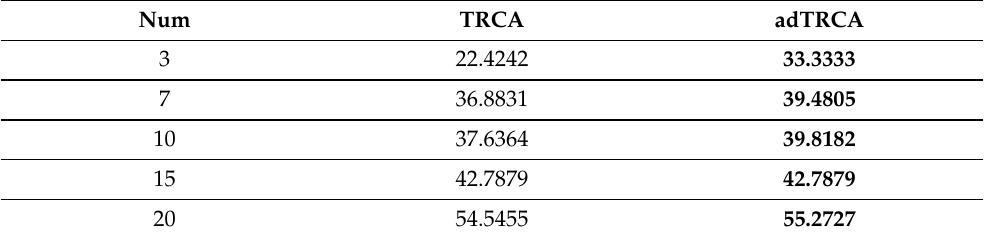
Table 7. Classification accuracy (%) on EPOC dataset with respect to the number of training